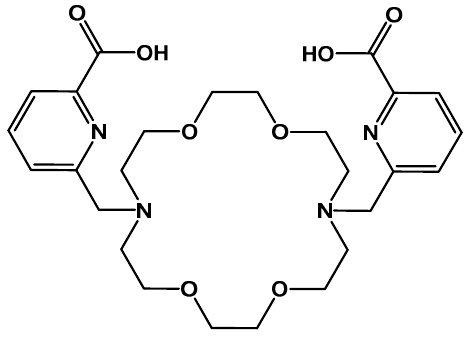
Figure 2. Structural formula of macropa.